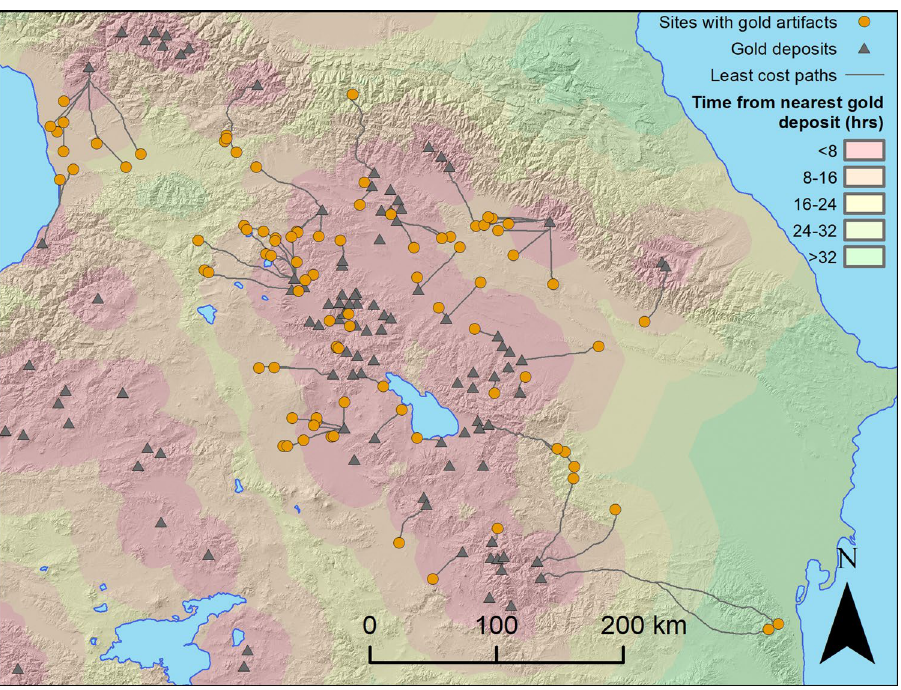
Figure 4. Map of gold deposits, gold findspots, and least cost paths from the nearest deposit to each